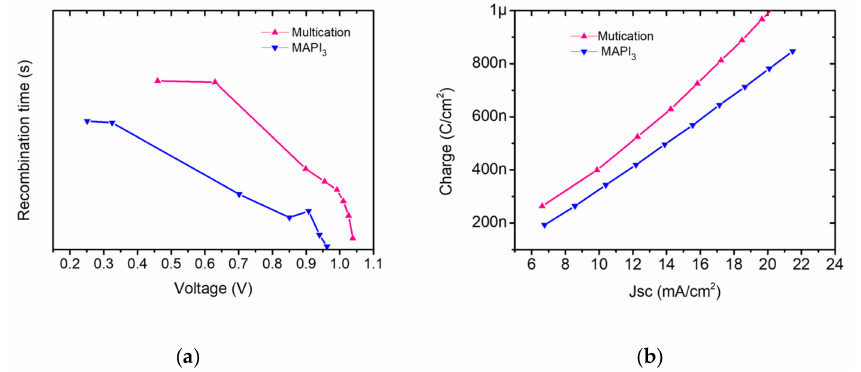
Figure 8. ( a ) Recombination time versus voltage, evaluated from transient photovoltage decay analysis of the PSCs. ( b ) Charge extraction curves of the PSCs obtained from transient photocurrent fall/rise